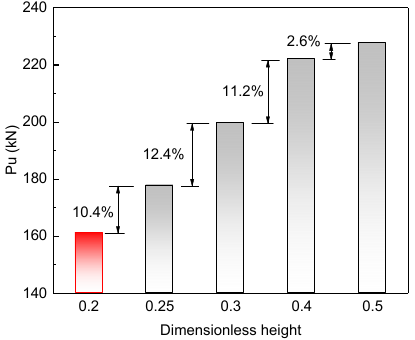
Figure 12. Effect of web height of connector and adding connector at column ends.